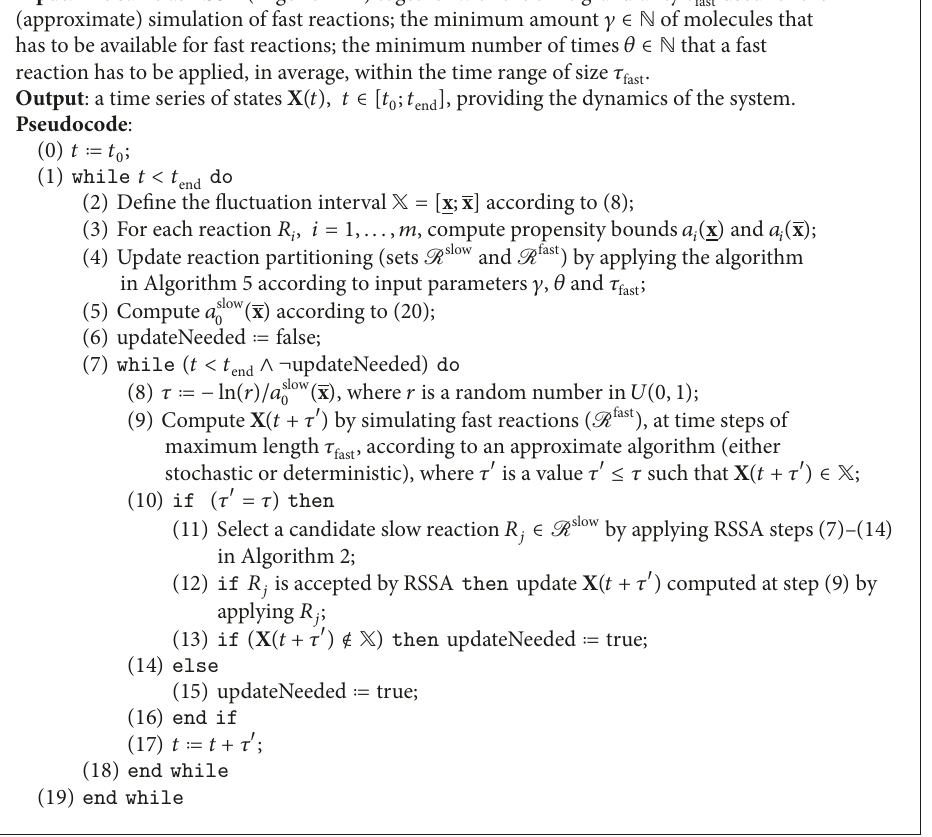
Algorithm 6: The hybrid rejection-based stochastic simulation algorithm (HRSSA, please refer to [21] for details). In HSimulator, step (9) is implemented by a deterministic Runge-Kutta numerical